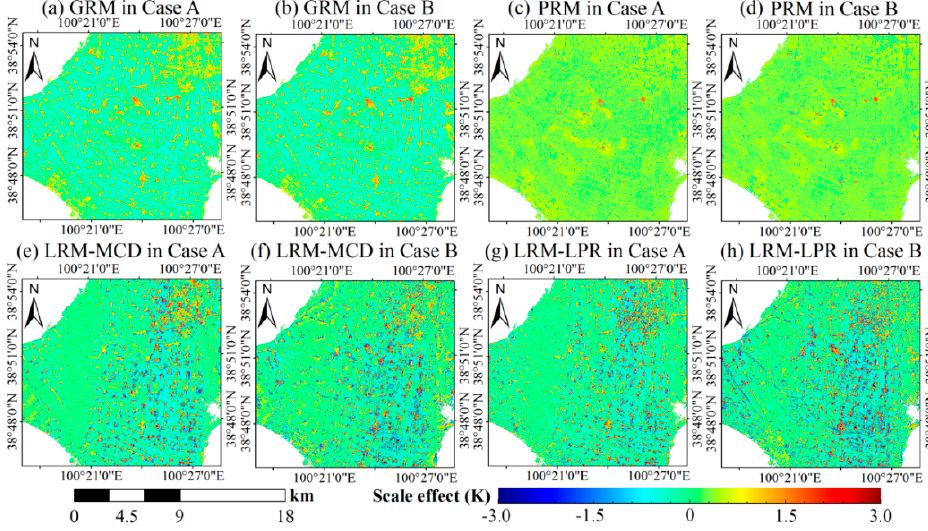
Figure 4. The quantified scale effects in downscaling the TASI simulated LST with ( a , b ) GRM, ( c , d ) PRM, ( e , f ) LRM-MCD, and ( g , h ) LRM-LPR.